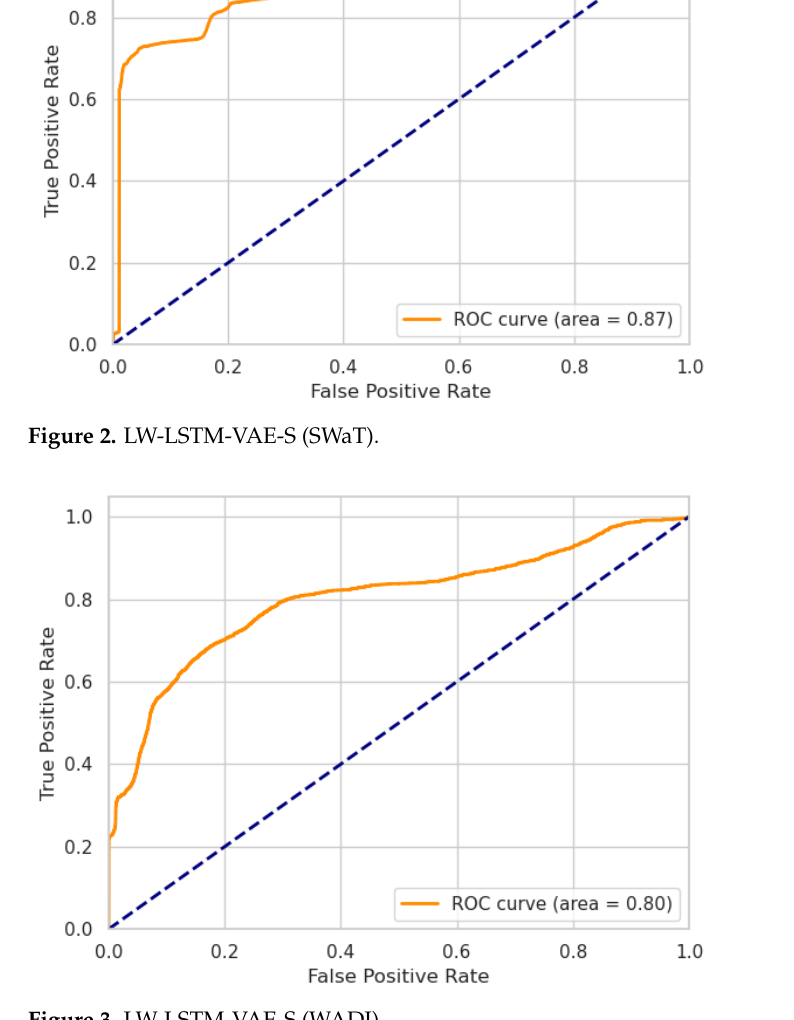
Figure 3. LW-LSTM-VAE-S